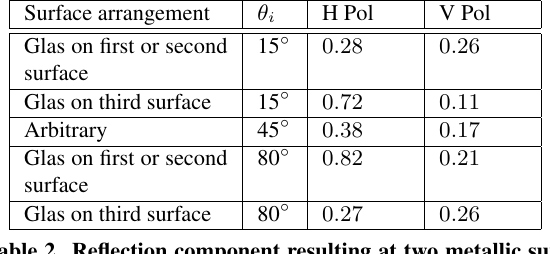
Figure 6. Alexanderplatz, intensity distribution of maxima for different polarizations and incidence